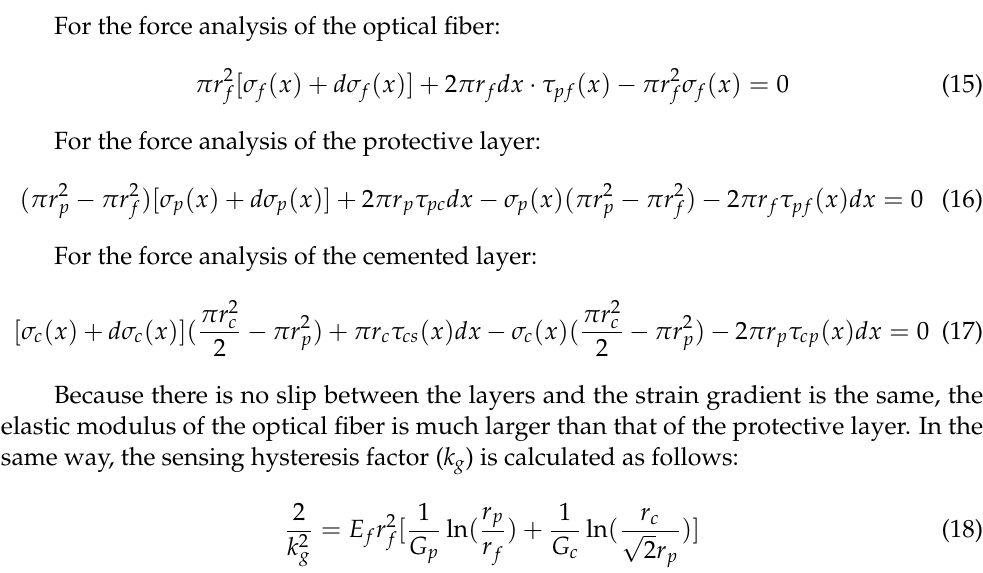
Figure 9. Schematic diagram of strain transfer between different layers in grooved-bonded